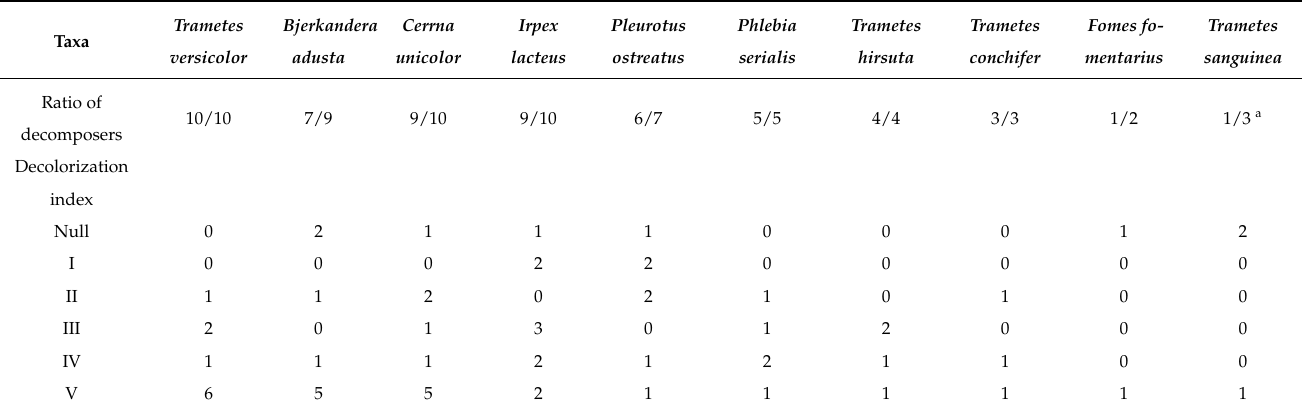
Table 2. The decolorization levels of fungal species containing the top-24 decomposers. The numbers in the table represent the counts of isolates from selected species corresponding to the decolorization levels